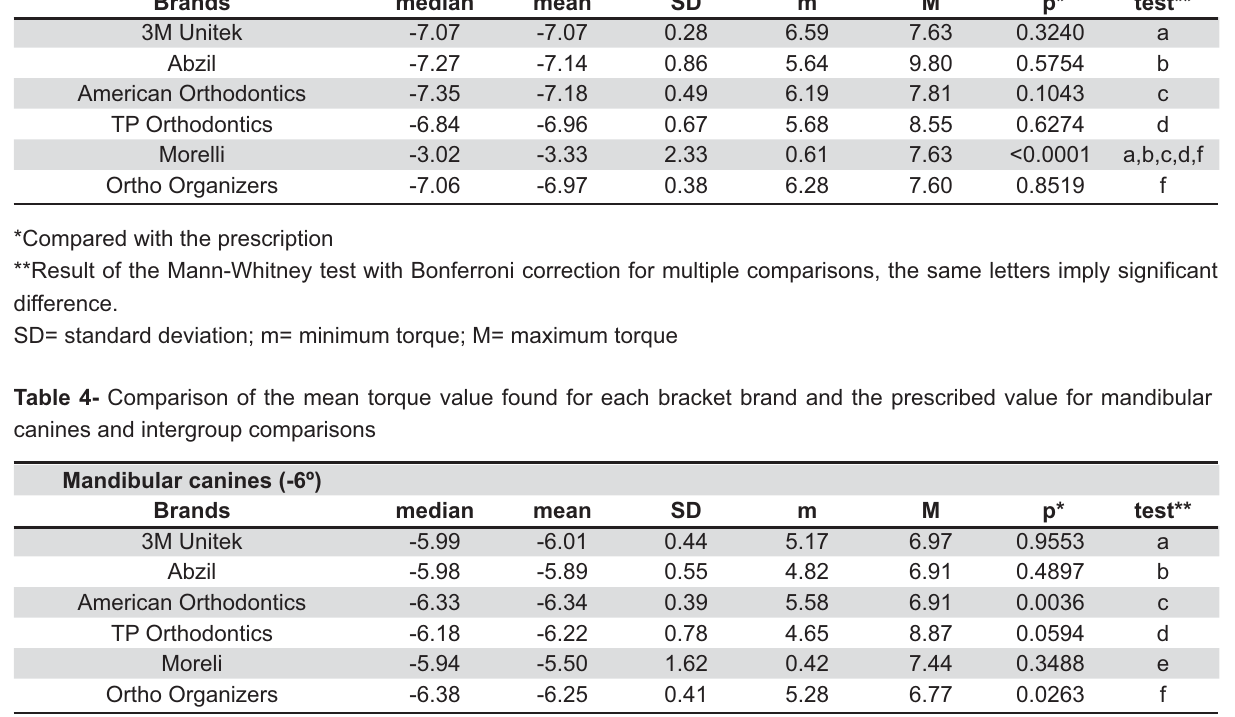
Table 3- Comparison of the mean torque value found for each bracket brand and the prescribed value for maxillary canines and intergroup comparisons Maxillary canines (-7º)